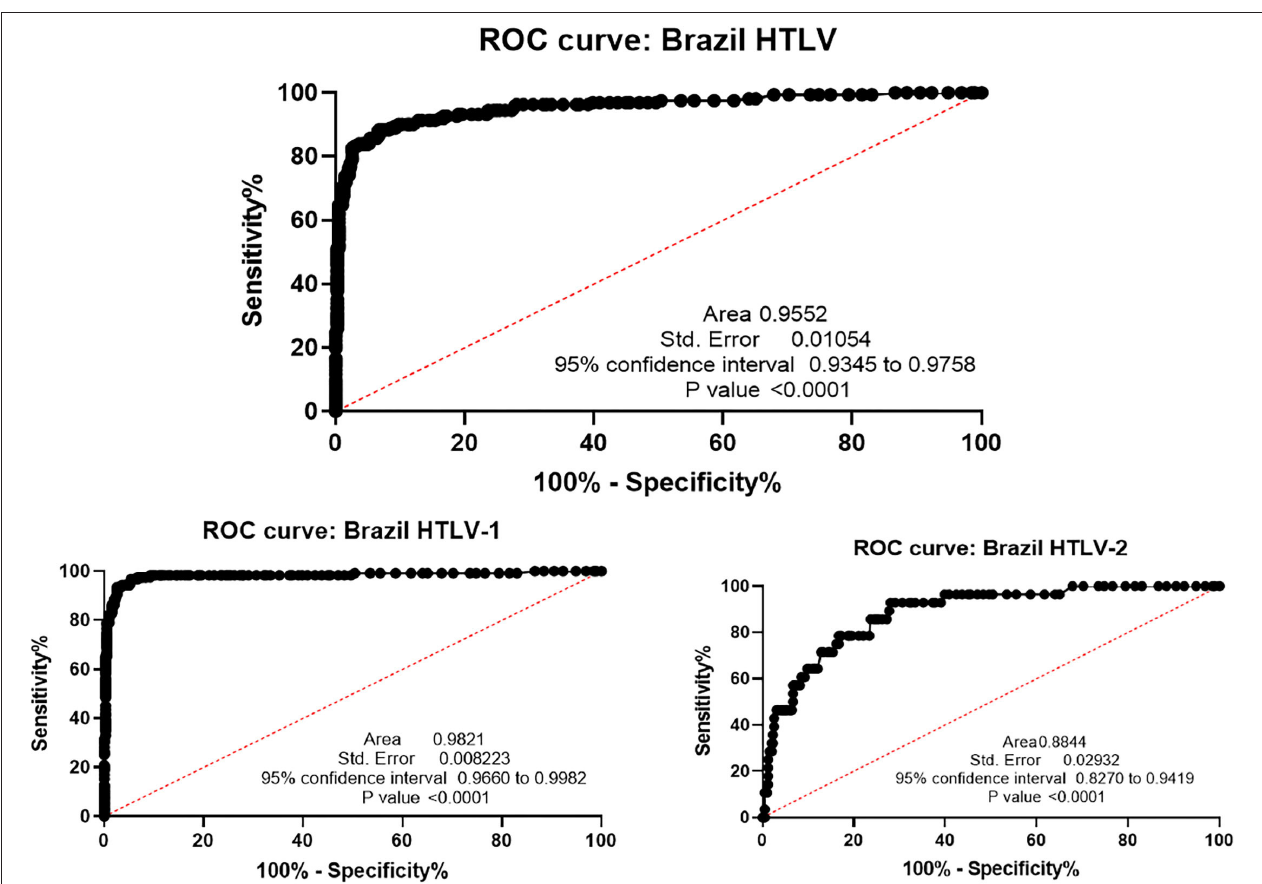
FIGURE 3 | ROC curve analysis of Brazilian global results. HTLV: area under the curve: 0.9552 (95% CI: 0.9345–0.9758), optimal cut-off: > 1.110, with 85.80 % sensitivity and 94.60% specificity at cutoff. HTLV-1: area under the curve: 0.9821 (95% CI: 0.9960–0.9982), optimal cut-off > 1.110, 96.77% sensitivity, and 94.60% specificity at cutoff. HTLV-2: area under the curve: 0.8844 (95% CI: 0.8270–0.9419), optimal cut-off > 0.9150, 64.29% sensitivity and 90.23% specificity at cut-off.